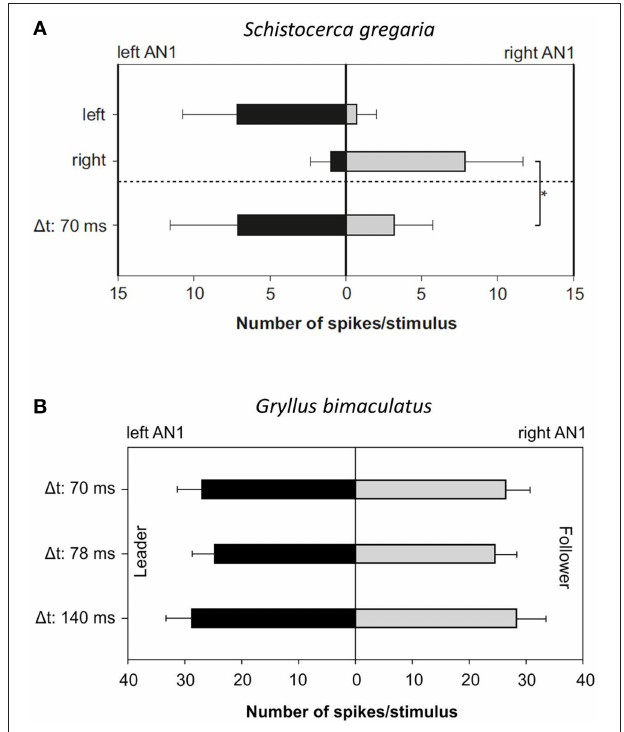
FIGURE 3 | Summary of the bilateral AN1 responses to a Mecopoda chirp in Schistocerca gregaria and G. bimaculatus . The chirp of a solo-singing Mecopoda was presented individually from both sides (left and right) or as a leader–follower presentation with a time lag of 70ms. (A) The mean bilateral AN1 response of five S. gregaria individuals indicated a significantly stronger excitation on the leader side ( p < 0.01; Mann–Whitney Rank Sum Test, Bonferroni corrected). (B) No significant differences at three different time delays were observed in G. bimaculatus (average responses obtained from 5